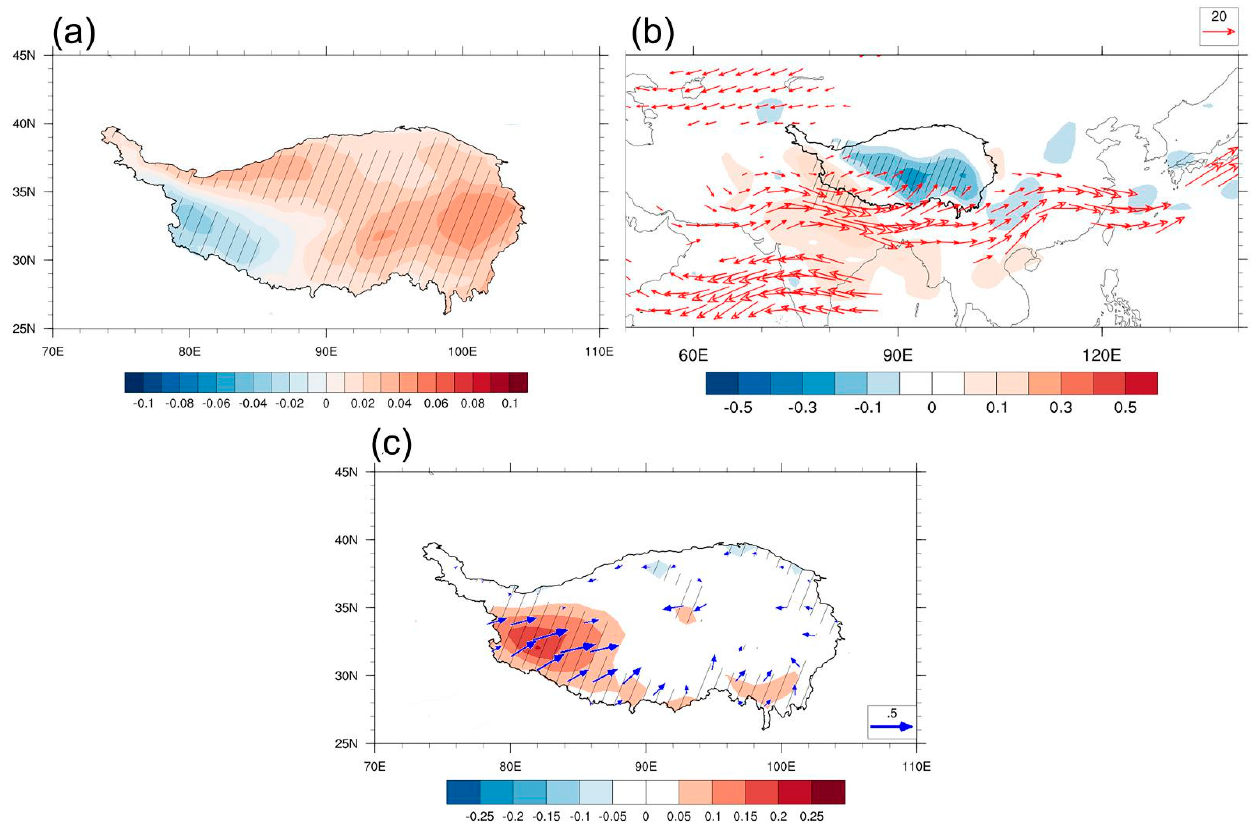
Figure 9. Anomalies in the interannual component of total cloud cover ( a ), water vapor flux exceeding the 95% confidence level (vector, kg m − 1 s − 1 ) and divergence (shading, 10 − 4 kg m − 2 s − 1 ) ( b ), surface wind vectors passing the 95% confidence level (vector, m s − 1 ), and wind speed (shading, m s − 1 ) ( c ) regressed on PC2-IA. Grid points with statistically significant anomalies passing the 95% confidence level are denoted by an oblique line.